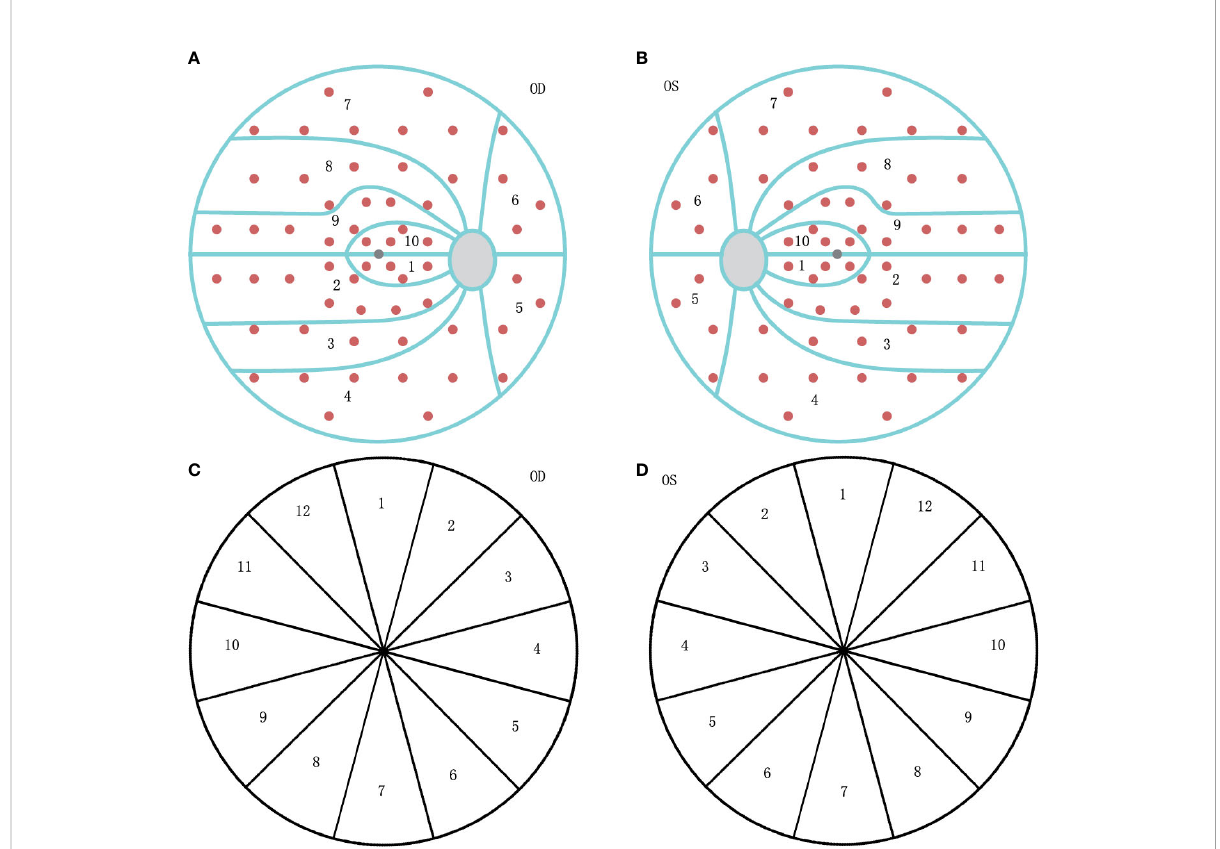
FIGURE 1 The diagram of visual fi eld (VF) clusters and retinal nerve fi ber layer (RNFL) clock-hour sector map. (A) The ten clusters are numbered 01 to 10 on the VF graph for the right eye (OD). (B) The ten clusters are numbered as 01 to 10 on the VF graph for the left eye (OS), mirrored as OD. (C) The clockwise number of twelve RNFL sectors on the OCT graph for the right eye (OD). (D) The counter-clockwise number of twelve RNFL sectors on the OCT graph for the left eye (OS), mirrored as